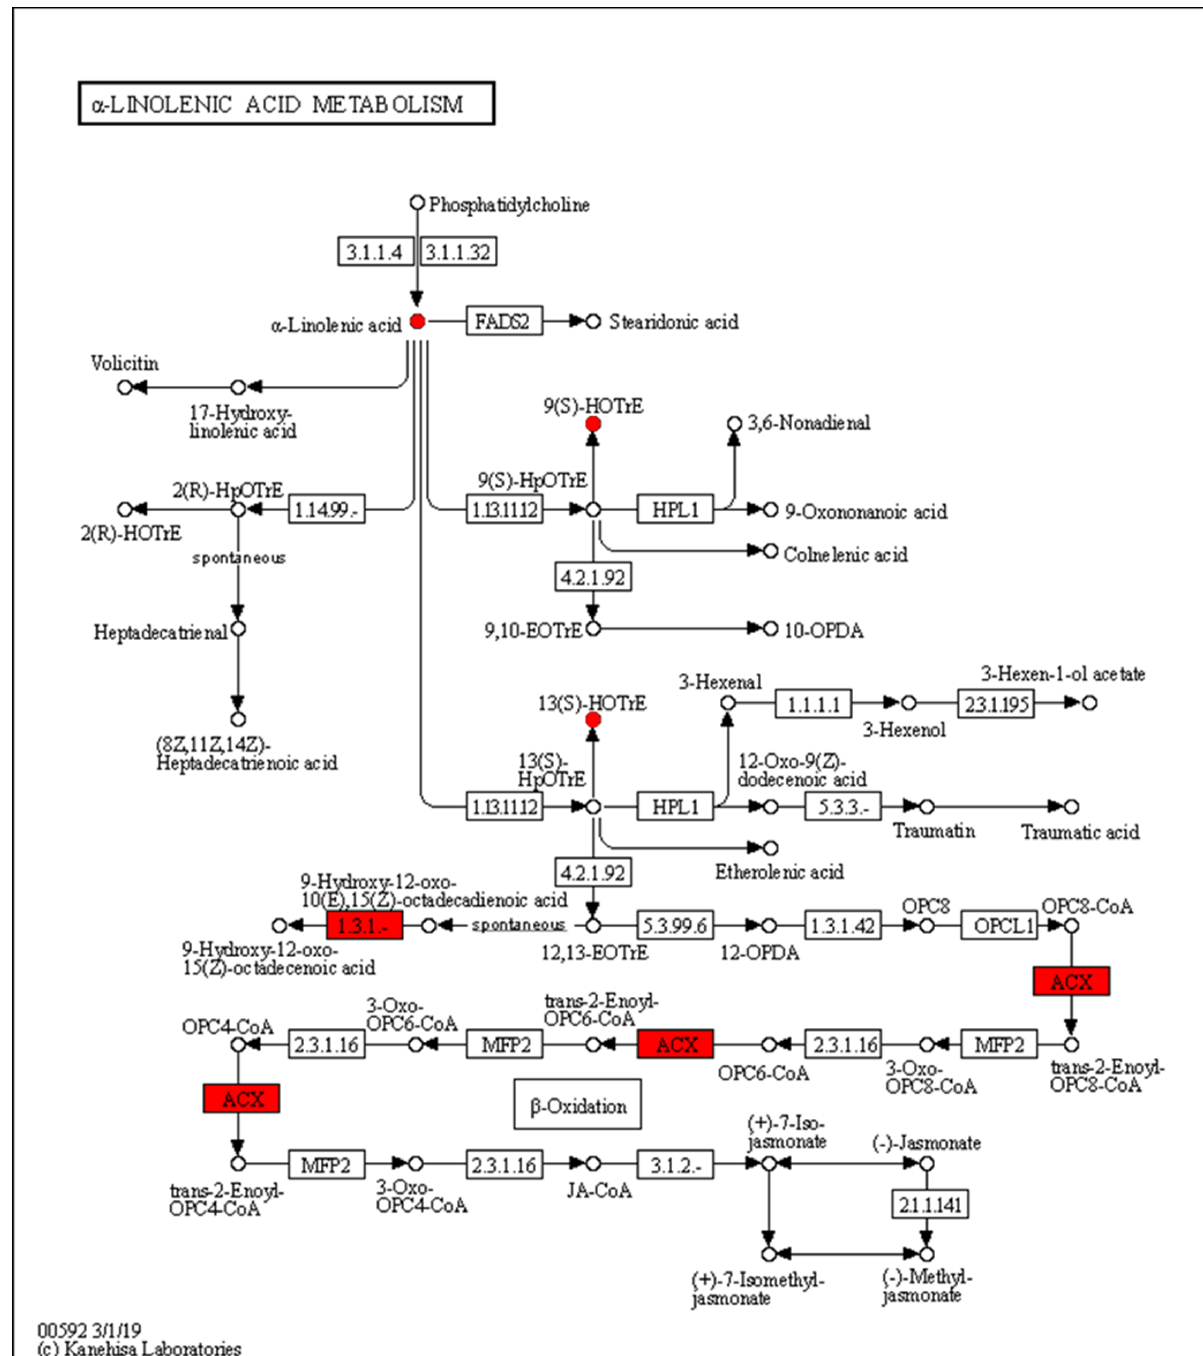
Figure 8. Enrichment of differentially expressed genes and oxidized lipid metabolites in the alpha- linolenic acid metabolism pathway (ko00592). Upregulated differentially expressed genes are marked with red boxes, and upregulated differentially expressed metabolites are marked with red circles.